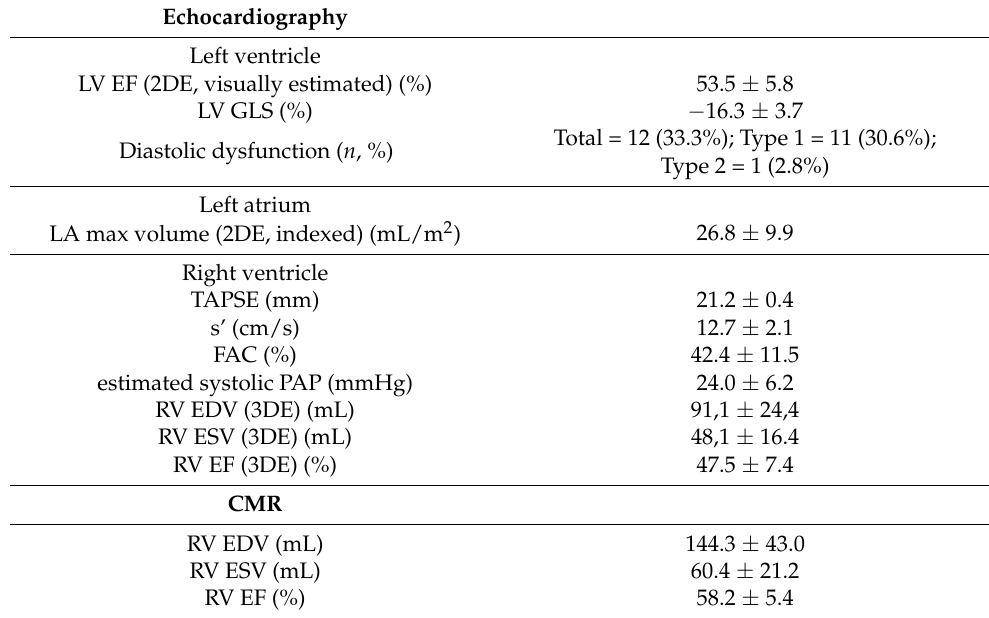
Table 3. Echocardiographic and CMR characteristics of the patients (group